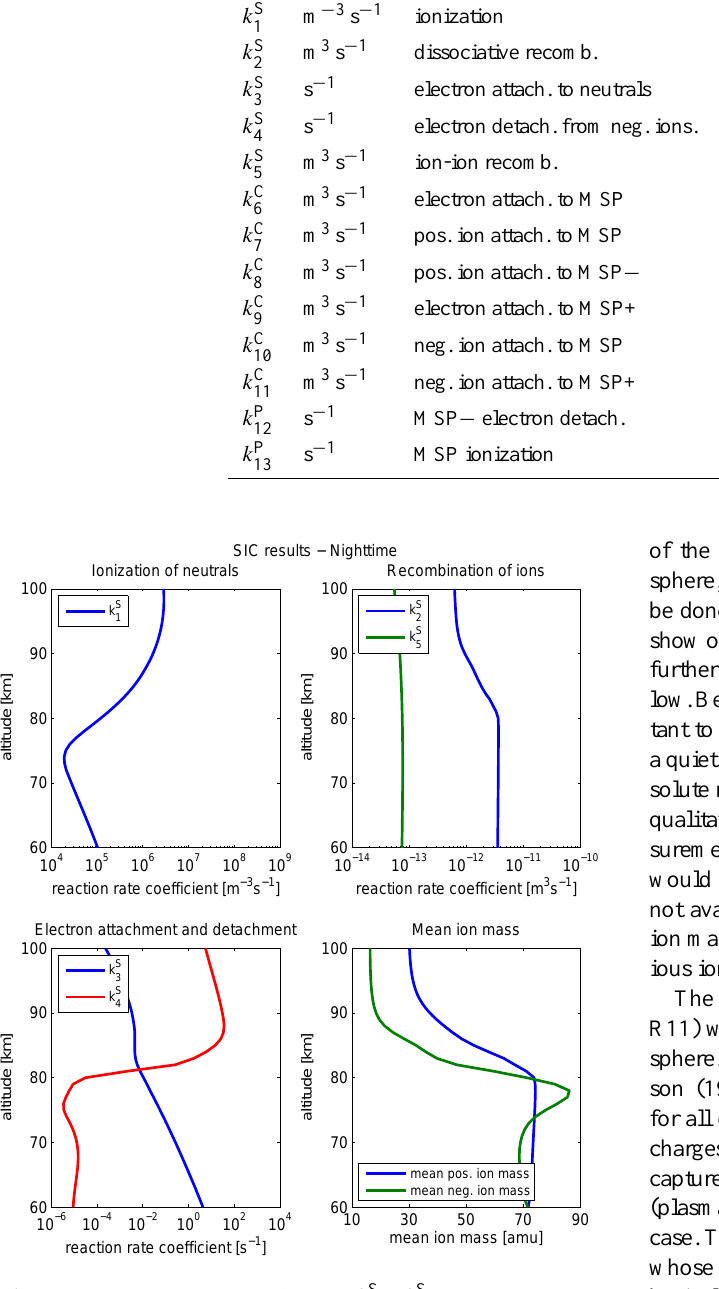
− k S in the appropriate 1 5